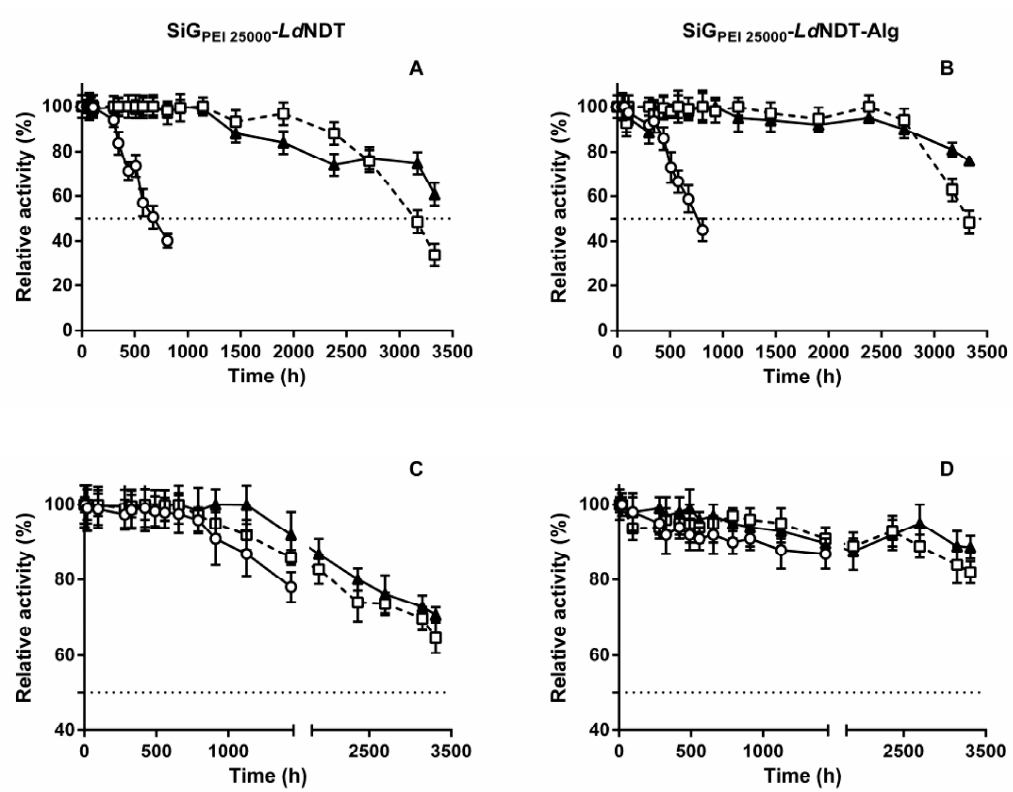
Figure 4. Thermal inactivation of SiG PEI25000 - Ld NDT ( A ) and SiG PEI25000 - Ld NDT-Alg ( B ) at different temperatures ( ▲ ) 30 °C, ( □ ) 50 °C, and ( ○ ) 60 °C. Effect of pH on the stability of SiG PEI25000 - Ld NDT ( C ) and SiG PEI25000 - Ld NDT-Alg ( D ). pH 5.0 ( ▲ ), pH 7.0 ( □ ), and pH 9.0 ( ○ ).